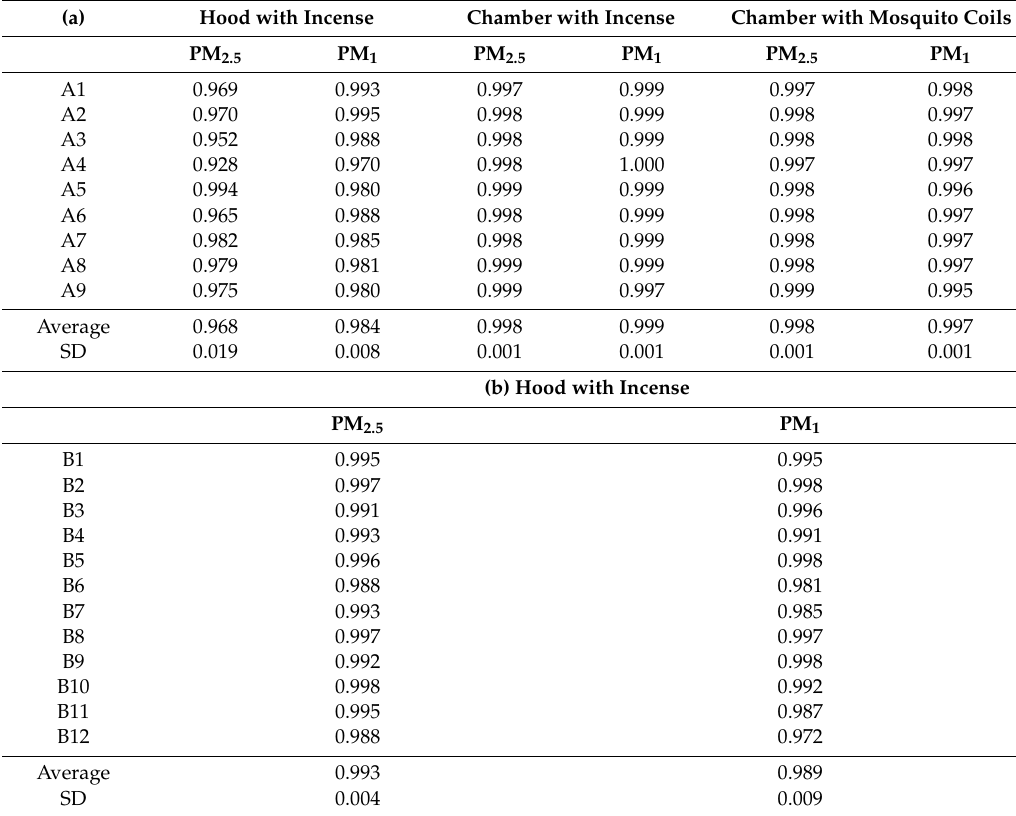
Table 2. Intra-class correlation coe ffi cient (ICC) from the hood and chamber experiments with duplicates for ( a ) PM 2.5 and PM 1 with 9 AS-LUNG-P sets with incense and mosquito coils and ( b ) PM 2.5 and PM 1 with 12 AS-LUNG-O sets with incense in the range of 0.1–200 µ g / m 3